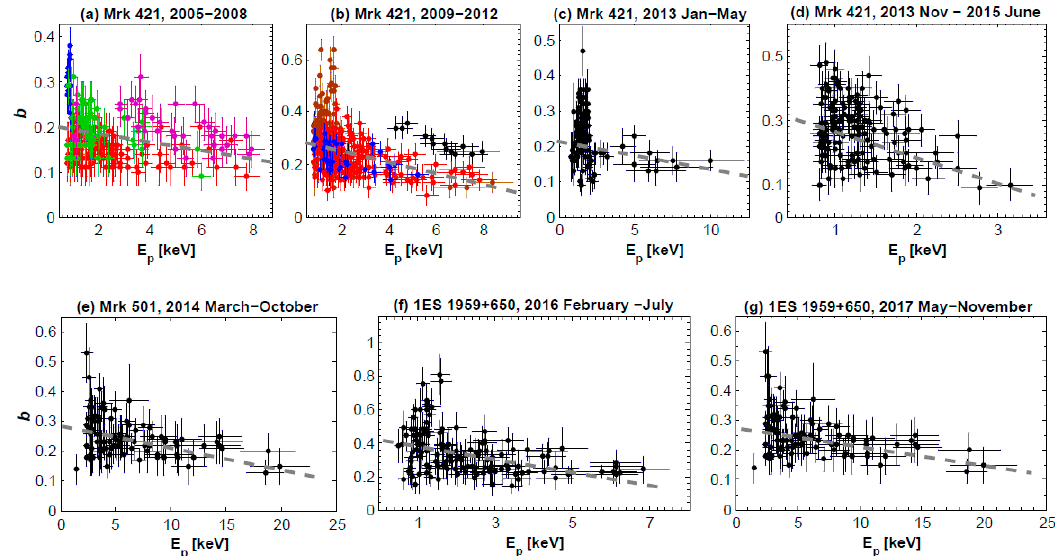
Figure 5. The E p - b anti-correlation for Mrk 421 ( a – d ), Mrk 501 ( e ) and 1ES 1959+650 ( f – g ) observed with Swift-XRT in different periods (reproduced from References [24–28,32]). In ( a , b ), the colored points correspond to the different intervals of the periods 2005–2008 and 2009–2012 (see References [24,25] for details). Gray dashed lines represent linear fits to the scatter plots.